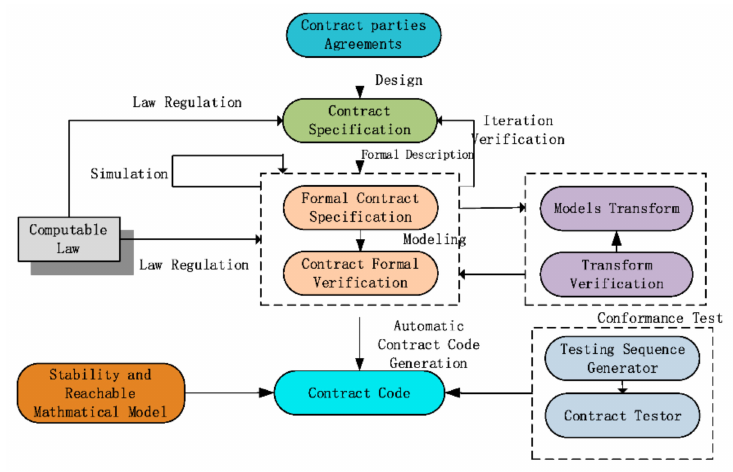
Figure 2. Smart contract